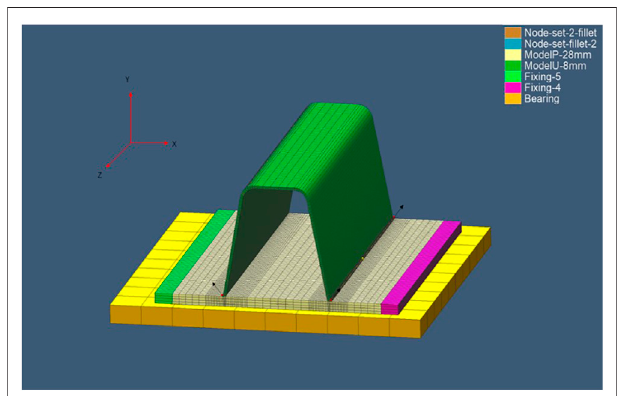
FIGURE 2 | Cross-sectional view of the U-rib stiffened